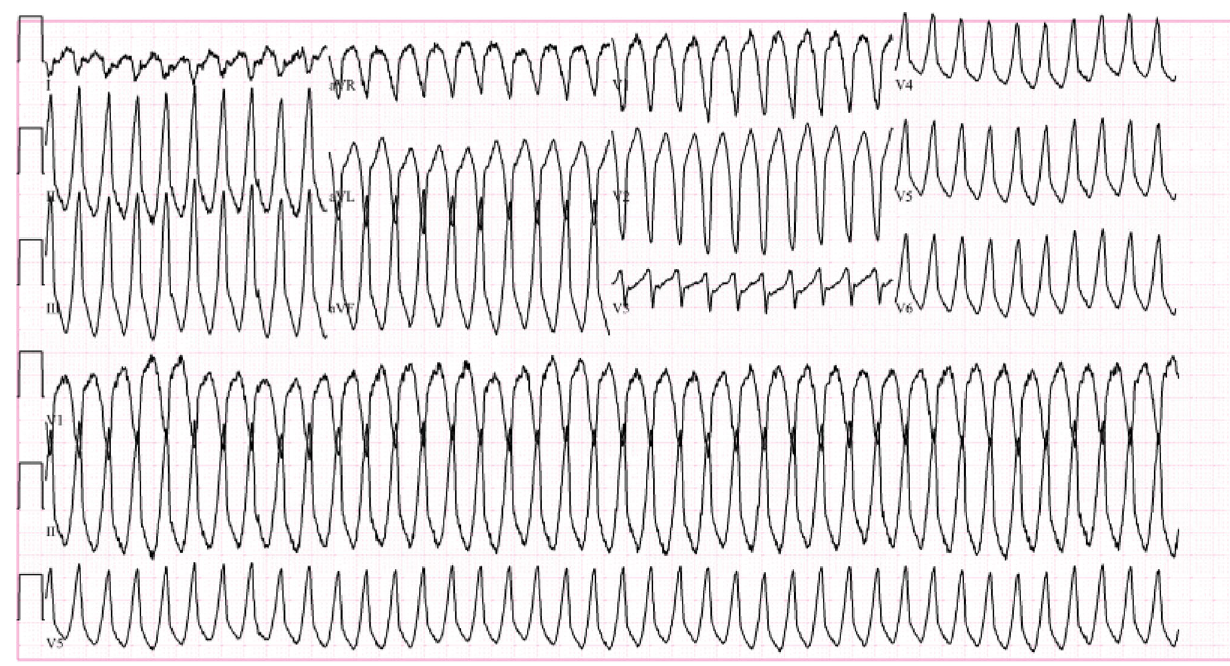
Figure 1: EKG showing right ventricular out fl ow tract ventricular tachycardia with left bundle branch pattern and inferior axis